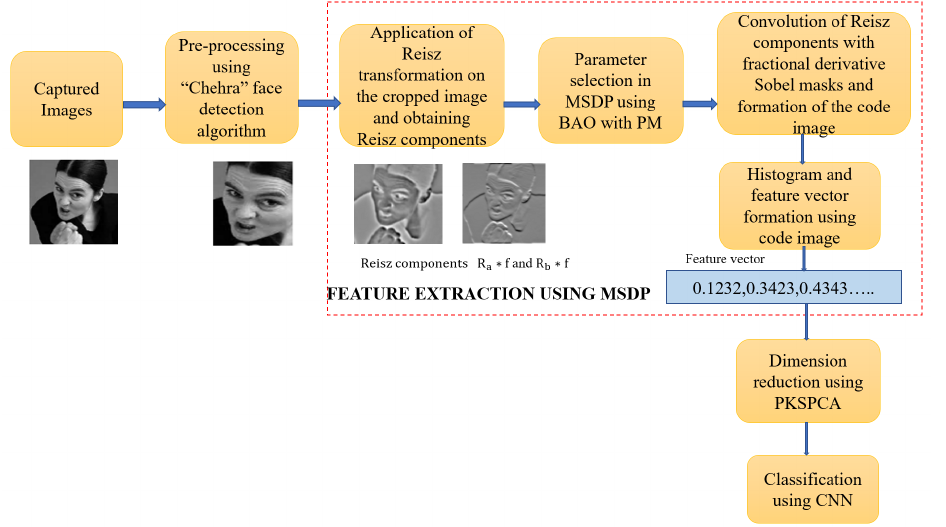
Figure 1. The proposed